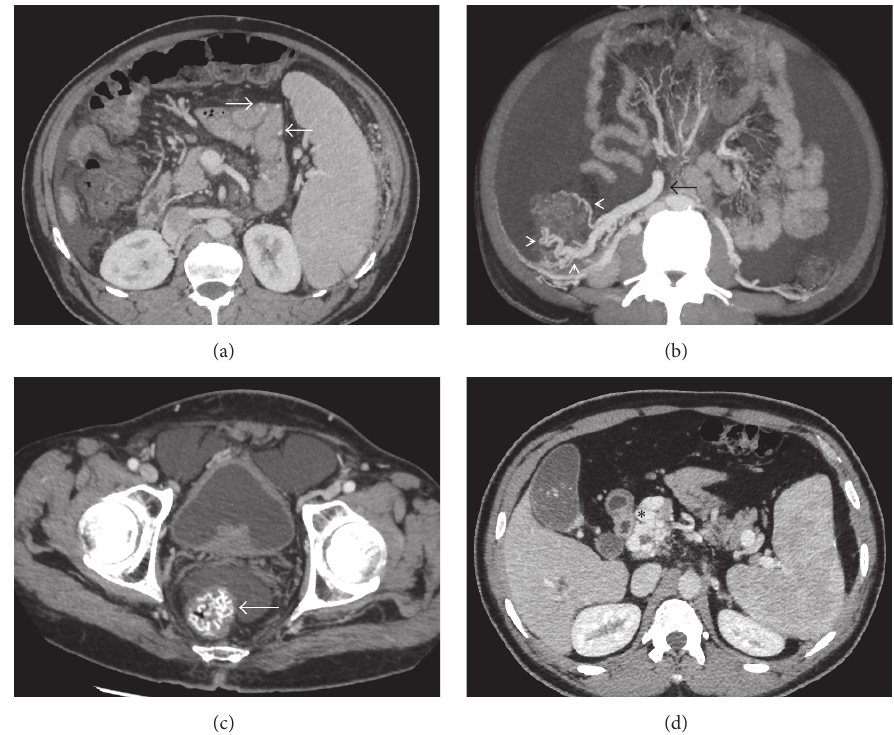
Figure 6: (a) Axial MIP image demonstrating multiple jejunal collaterals (arrows); (b) axial-oblique MIP CECT image showing multiple pericolonic collaterals (arrowheads) arising from the superior mesenteric vein (arrow); (c) axial MIP CECT image showing multiple rectal collaterals (arrow); (d) axial CECT image showing multiple paracholedochal collaterals (asterisks) encircling the common bile duct (arrow) in a patient with EHPVO.